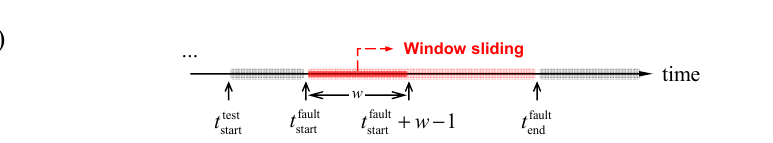
Figure 1. Proposed fault isolation method based on CART-based variable ranking: ( a ) fault isolation for the entire fault region (denoted as Method 1 ); ( b ) fault isolation using time window sliding (denoted as Method 2 ).